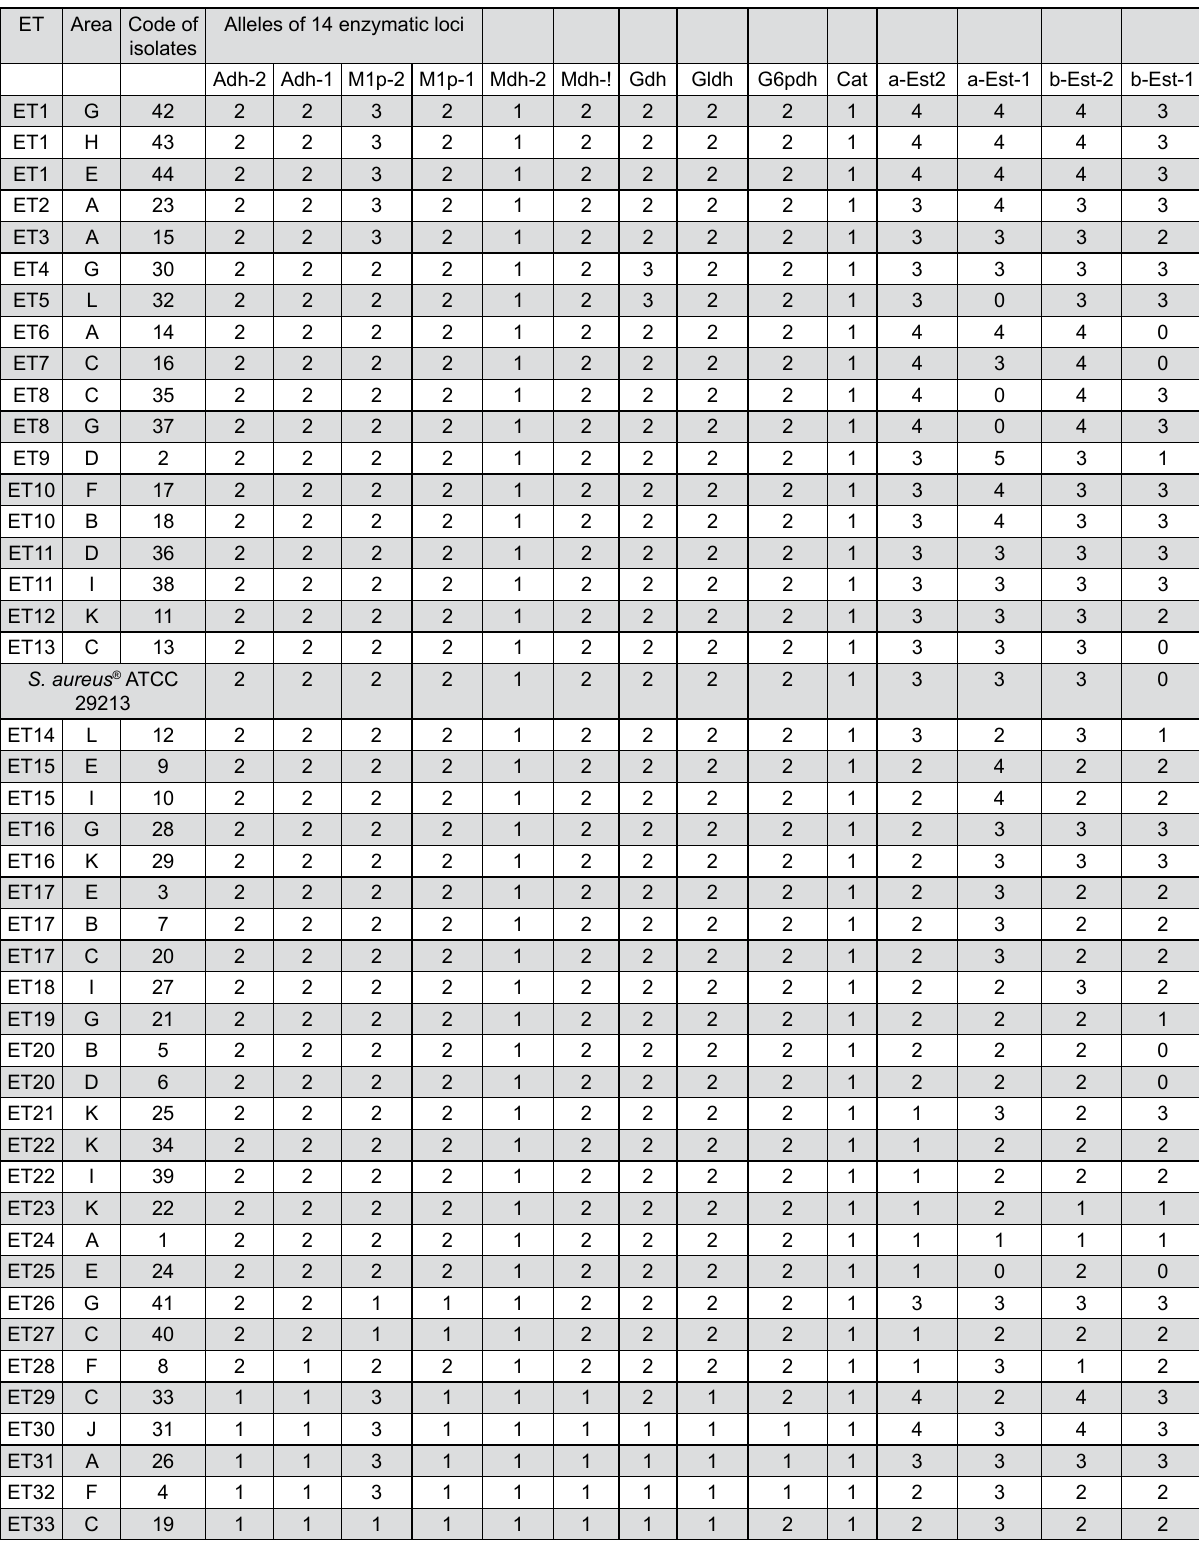
Figure 3- Allelic profiles of the 44 S. aureus isolates (33 S. aureus strains ETs) isolated from clinical environments (air) at the School of Dentistry at Piracicaba, State University of Campinas, São Paulo,